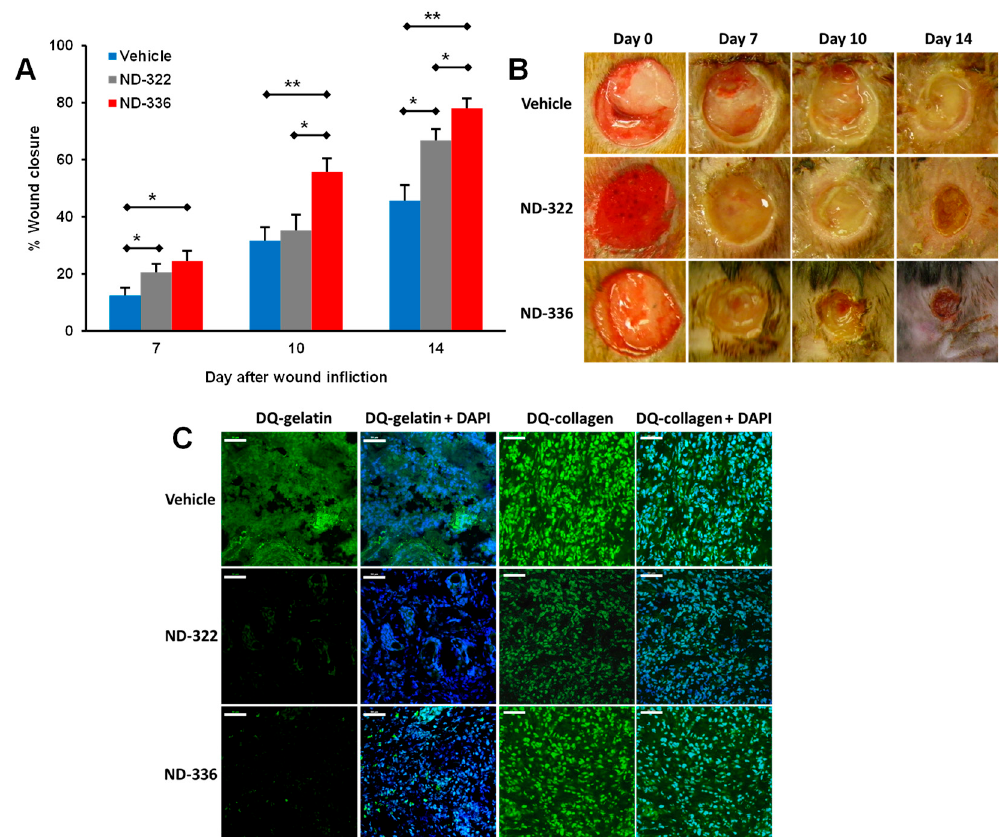
Figure 3. Selective MMP-9 inhibition accelerates diabetic wound healing. ( A ) Wound healing after treatment with 100 μ g/wound/day of ( R,S )-ND-336, ( R,S )-ND-322, or vehicle. Mean ± standard error of the mean (SEM); n = 8/group on days 7, 10, and 14; * p < 0.05, ** p < 0.01 by Mann–Whitney U test. ( B ) Representative images of the wounds. ( C ) In-situ zymography of wounds with DQ-Gelatin and DQ-Collagen indicates that ( R,S )-ND-336 inhibits MMP-9 but not MMP-8, while ( R,S )-ND-322 inhibits MMP-9 and poorly inhibits MMP-8. Reproduced from Gao et al